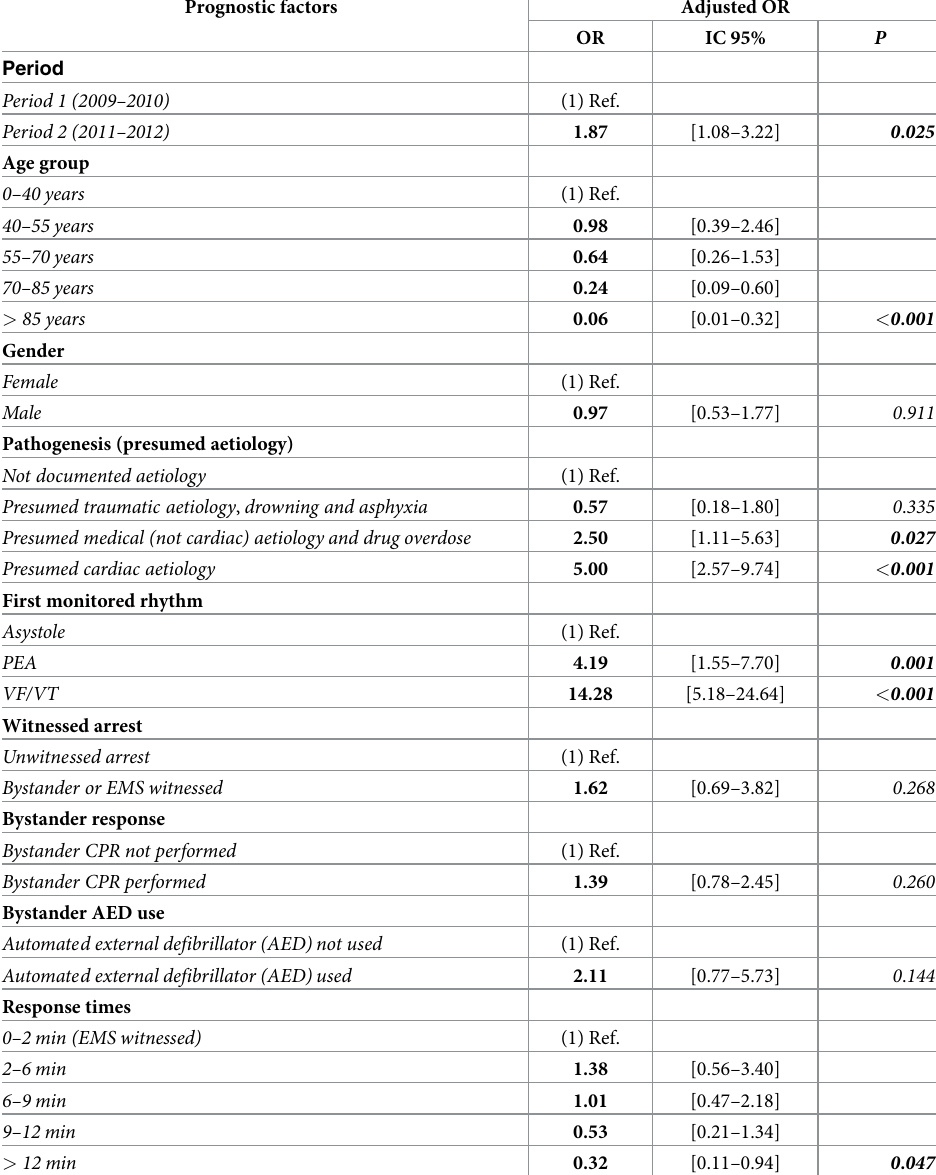
Tachycardia. CPR: Cardiopulmonary Resuscitation. AED: Automated External